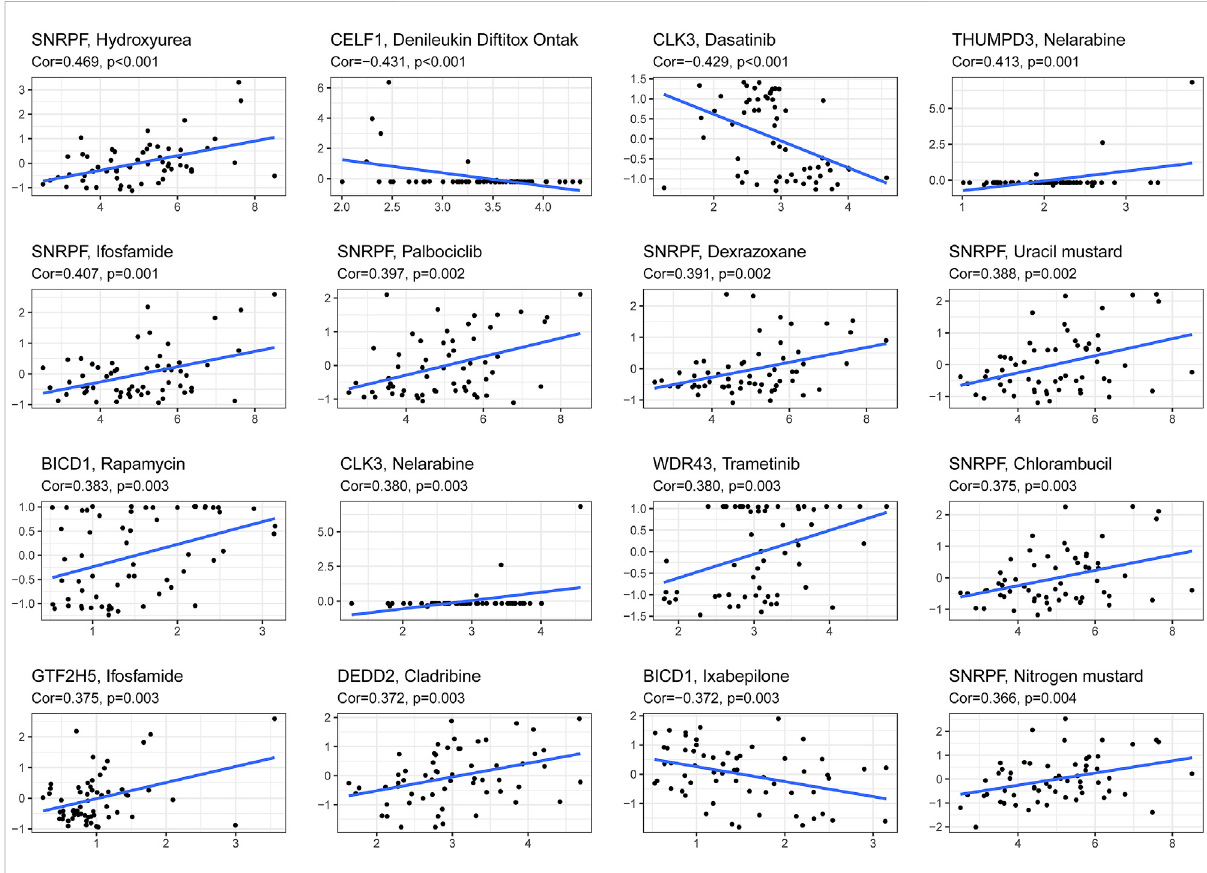
FIGURE 8 The correlation between genes in the signature and z-score values of chemotherapeutic drug sensitivity was calculated based on cellminer